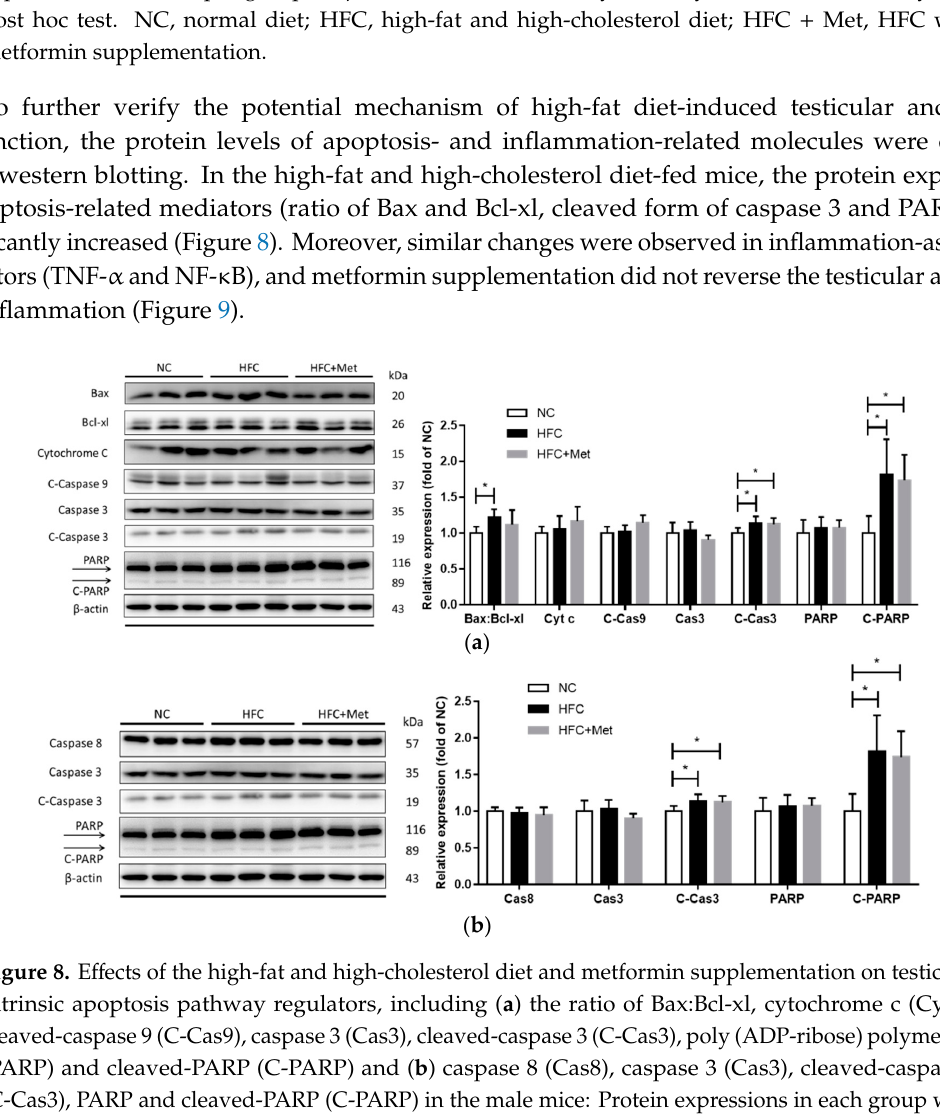
Figure 7. Effects of the high-fat and high-cholesterol diet and metformin supplementation on testicular antioxidants (superoxide dismutase (SOD), catalase (CAT) and glutathione peroxidase (GPx) activity) and malondialdehyde (MDA) content in the male mice: Data are expressed as means ± SD of duplicate experiments ( n = 6–9 per group). * p < 0.05 as determined by one-way ANOVA followed by LSD